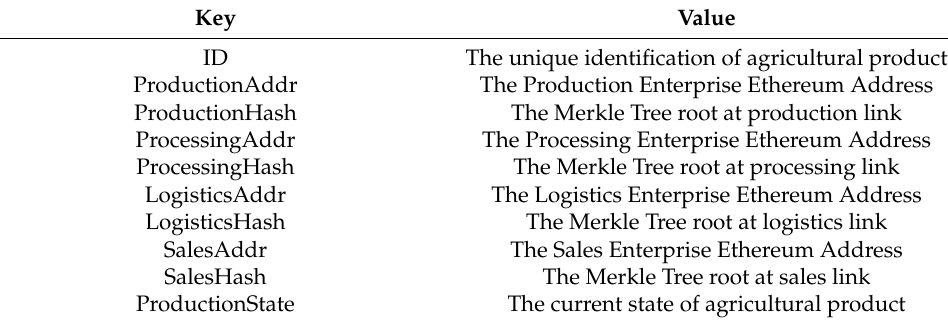
Table 2. On-chain storage